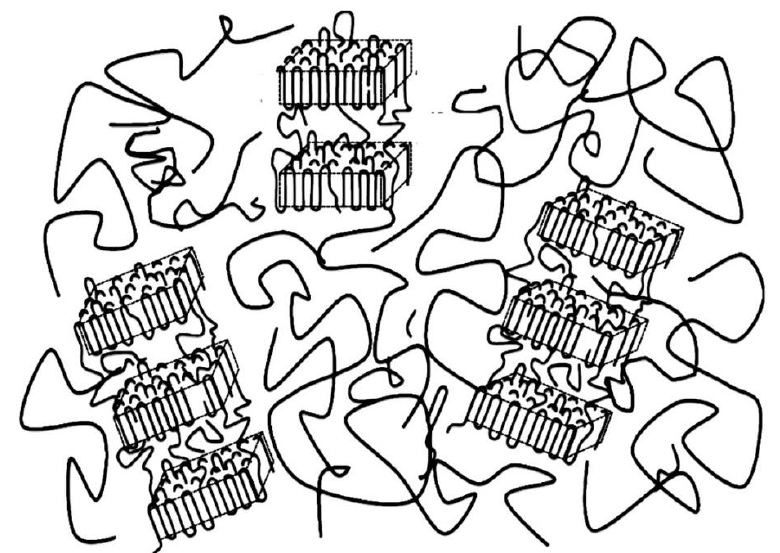
Figure 11. Schematic illustration of the sparsely distributed lamellar stacks in the matrix of polymer melts. This illustrates an early stage of polymer crystallization (adapted from reference [19] with a permission. The figure has been slightly